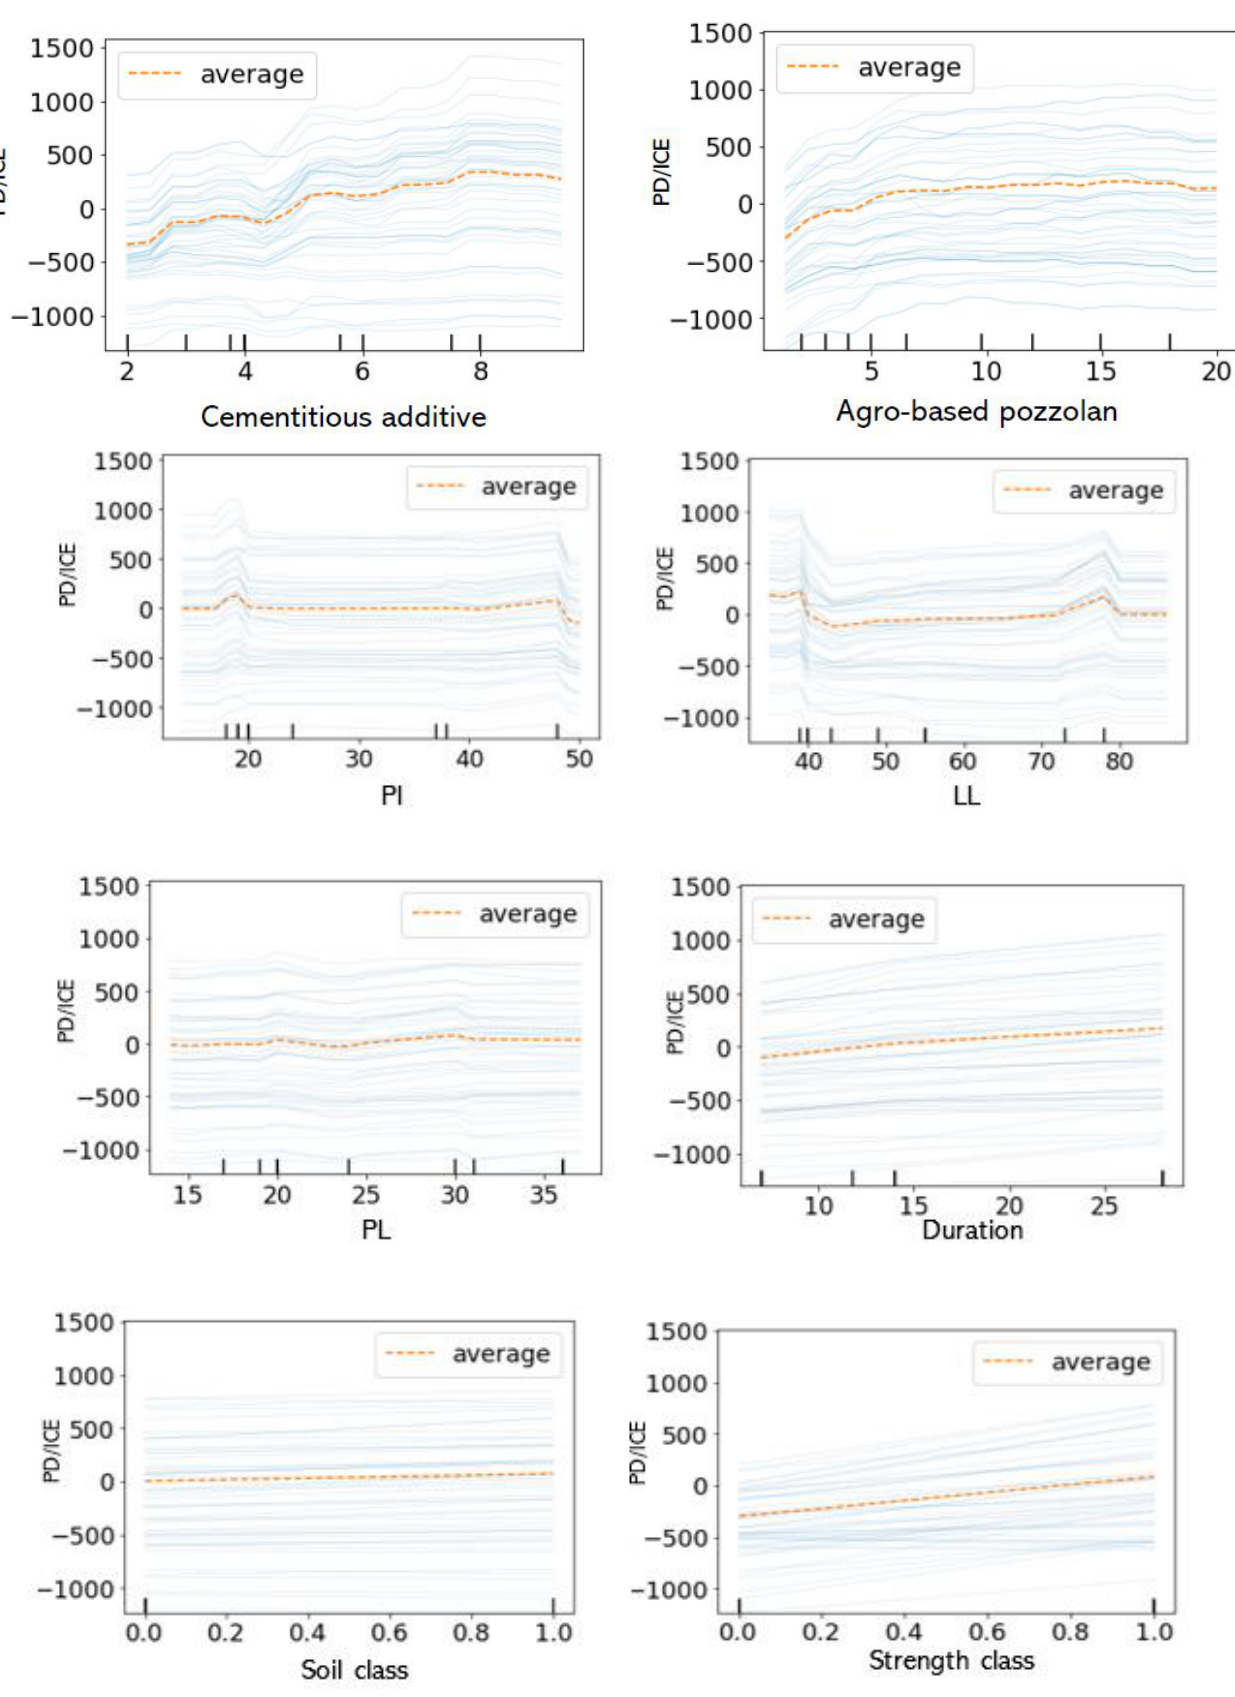
Figure 12. Partial dependence and individual conditional exception plots.